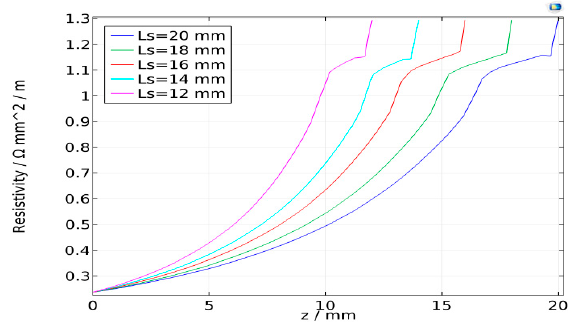
Figure 11. Resistivity distribution along the wire. Table 1. The average resistivity for different stickout.